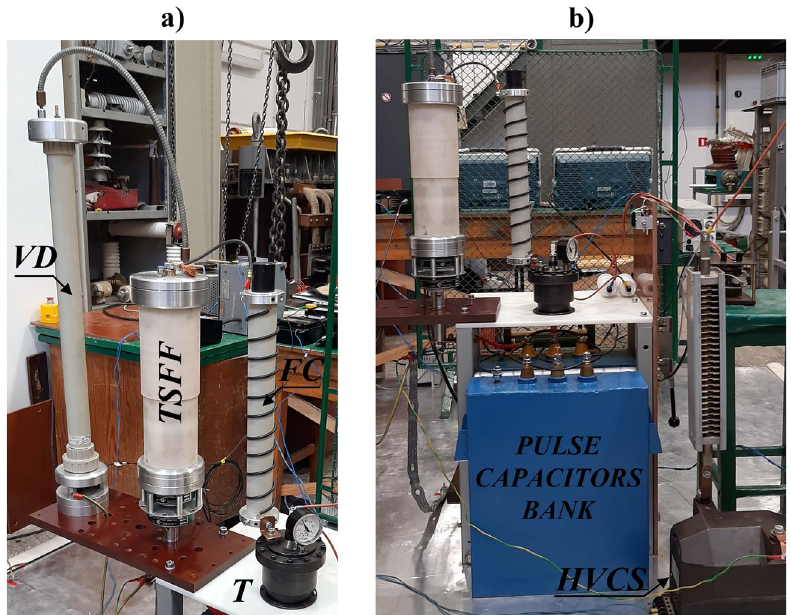
Figure 13. Photographs of the TSFF-based PFS laboratory test stand supplied from a battery of pulse capacitors. Designations according to Fig.